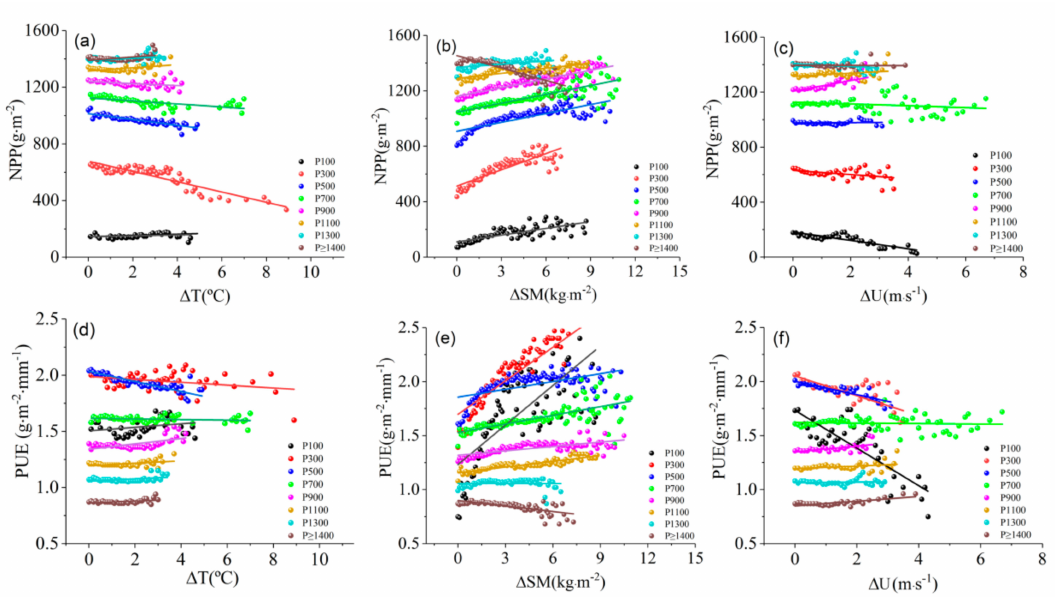
Figure 13. Trends of annual NPP and PUE with ∆ T ( a , d ), ∆ SM ( b , e ), and ∆ U ( c , f ) in different precipitation climate